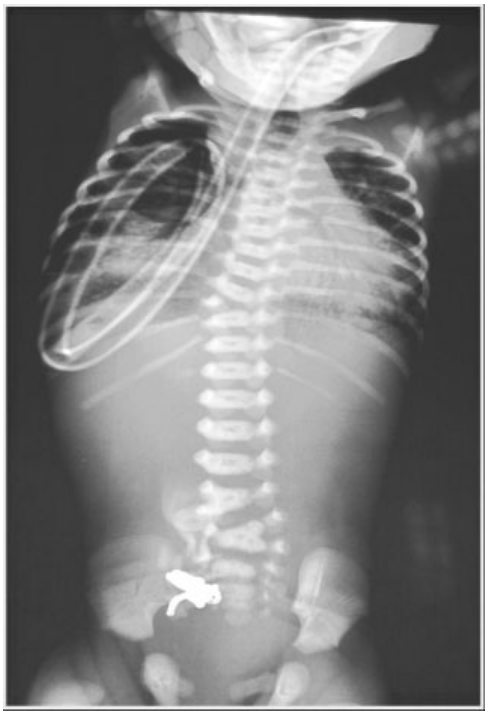
Fig. 1 X-ray showing catheter in right pleural cavity and gasless abdomen.